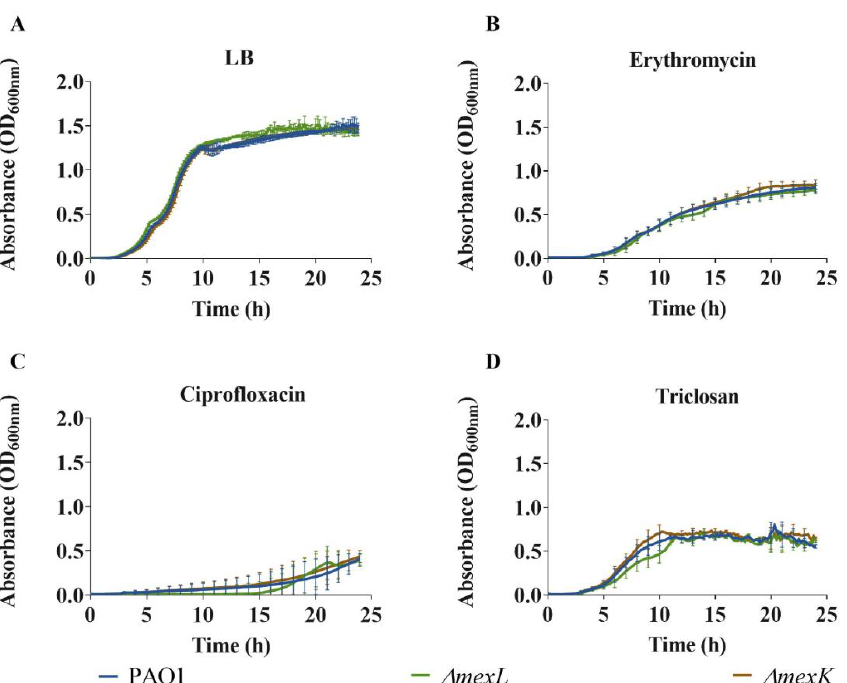
Figure 3. Analysis of growth in LB for PAO1, Δ mexL , and Δ mexK strains in ( A ) absence and in ( B – D ) presence of antimicrobials. Growth (OD 600 ) was measured for 24 h in the presence of compounds suggested to be MexJK substrates — ( B ) erythromycin and ( C ) triclosan — as well as in the presence